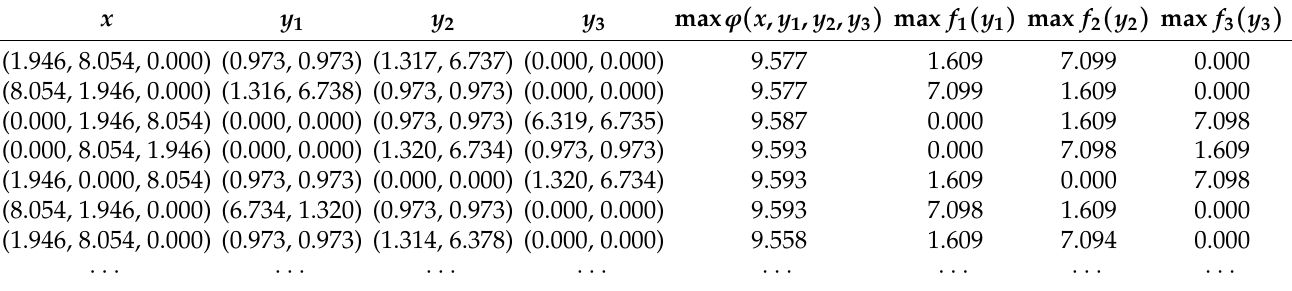
Table 4. The IPSO algorithm for solving the numerical result of Example